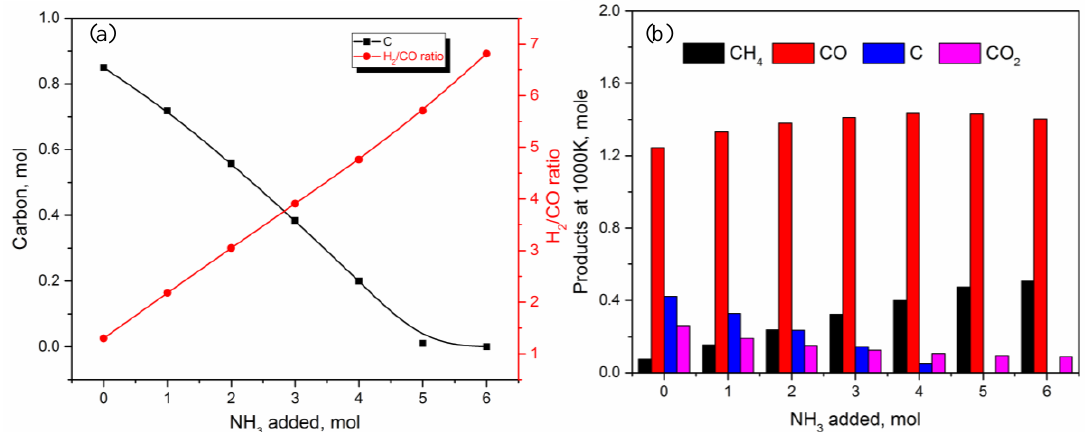
Figure 8. ( a ) Effect of ammonia content on syngas quality (H 2 /CO ratio) and carbon content at 1000 K; ( b ) distribution of carbon-containing products at 1000 K as a function of ammonia content.